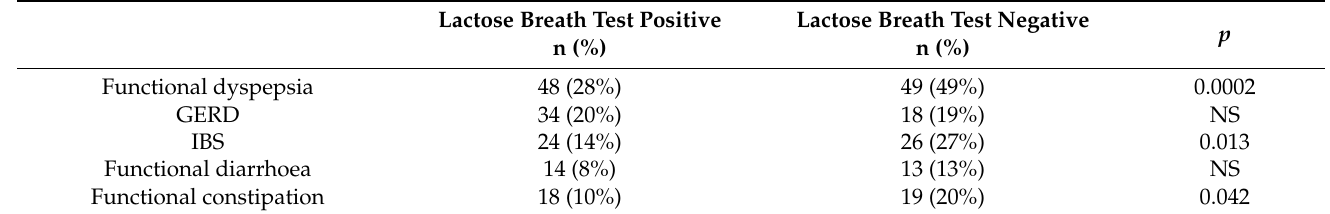
Table 1. Prevalence of functional dyspepsia, GERD, IBS, functional diarrhoea and functional consti- pation in patients with and without lactose